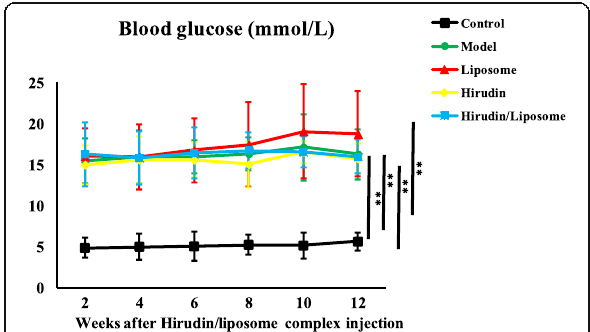
Fig. 5 After STZ injection, levels of blood glucose in the Model, Liposome, Hirudin and the Hirudin/liposome complex groups were significantly higher compared with the Control group, although the hirudin/liposome complex treatment did not lead to a decrease in the blood glucose level in DN rat models. Control group (n = 10), model group ( n = 7), liposome group (n = 7), hirudin group ( n = 8), hirudin/liposome complex group (n = 7): P <0.05;*: P